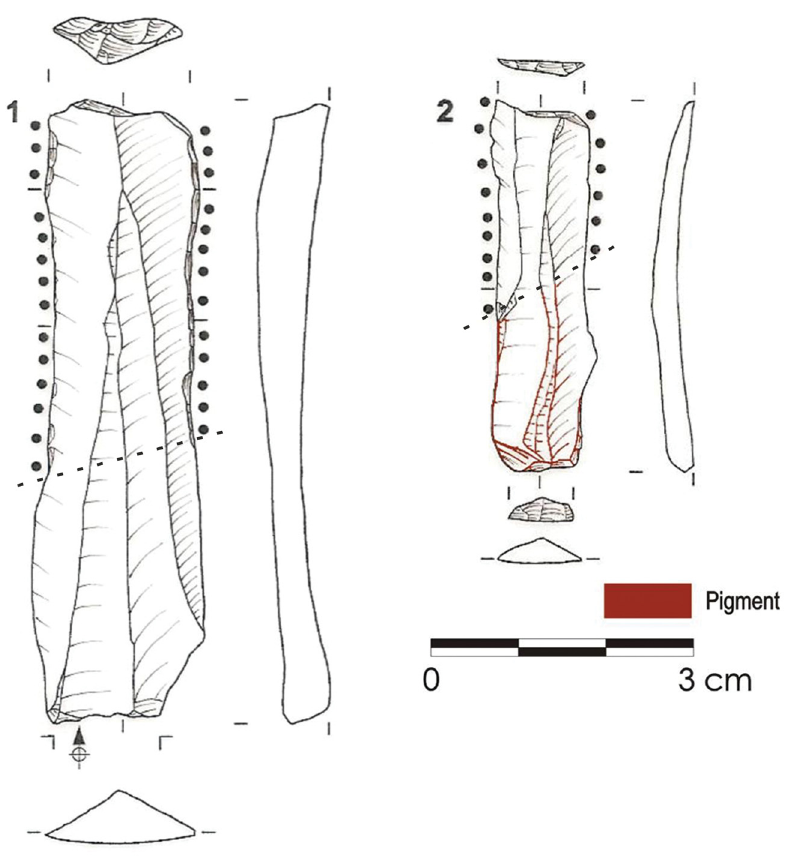
Figure 2: Two sickles found in the Neolithic fl int shafts. The discontinue line shows the diagonal limit of luster. ( 1 ) Number: 7865/1073; ( 2 ) The proximal part presents red pigment. Number: 7965/227. Drawings: Paco Fernández © Casa Montero